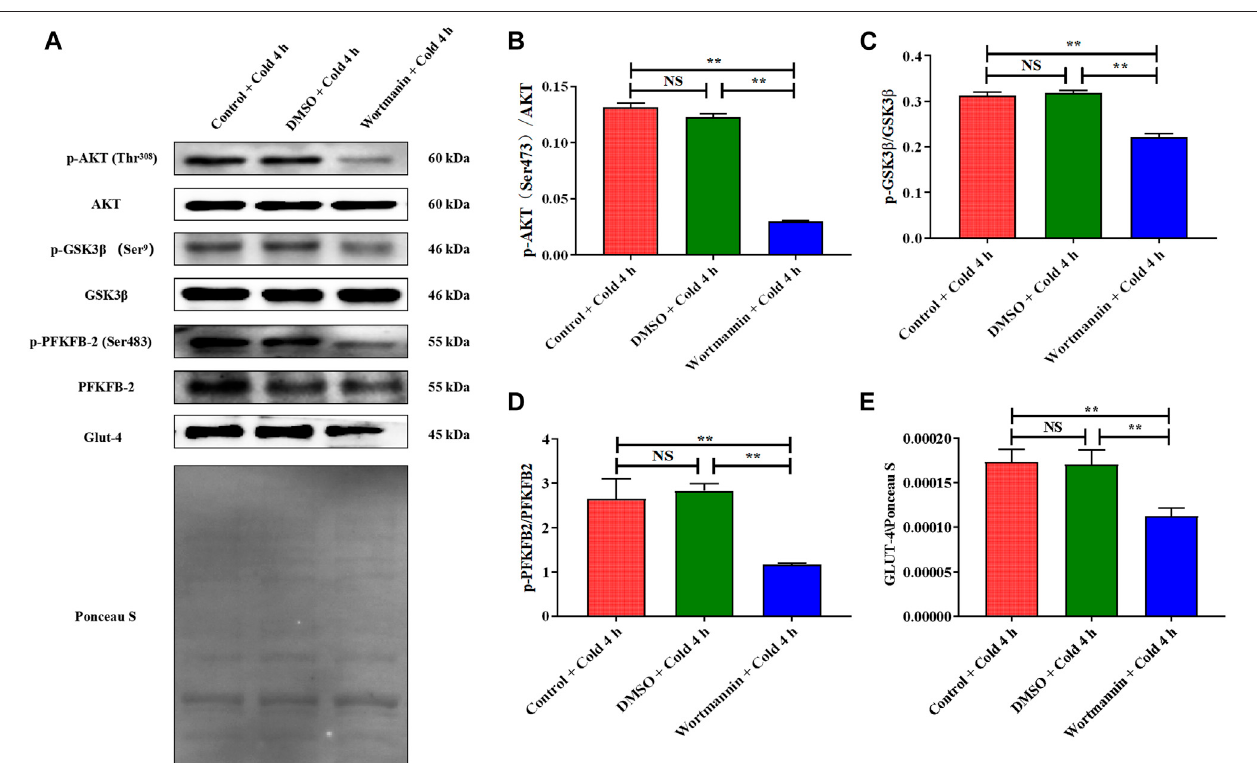
FIGURE8| TheinhibitionofAKTresultsinthedecreaseofglucosemetabolisminskeletalmuscleofmiceunderacutecoldexposure. (A) Westernblottingresultsof glucose metabolism related proteins in each group. Effects of wortmannin on protein expression levels and phosphorylation of AKT (B) , GSK3 β (C) , PFKFB2 (D) and GLUT-4 (E) inskeletalmuscleofmiceafteracutecoldexposure.Thedataarepresentedasthemean ± SEM(n (cid:1) 8).Statisticallysigni fi cantdifferencesareindicated;* p < 0.05, ** p < 0.01. AKT, protein kinase B; GSK3 β , glycogen synthase kinase-3 β ; PFKFB2, 6-phosphofructo-2-kinase/fructose-2,6- biphosphatase 2; GLUT-4, glucose